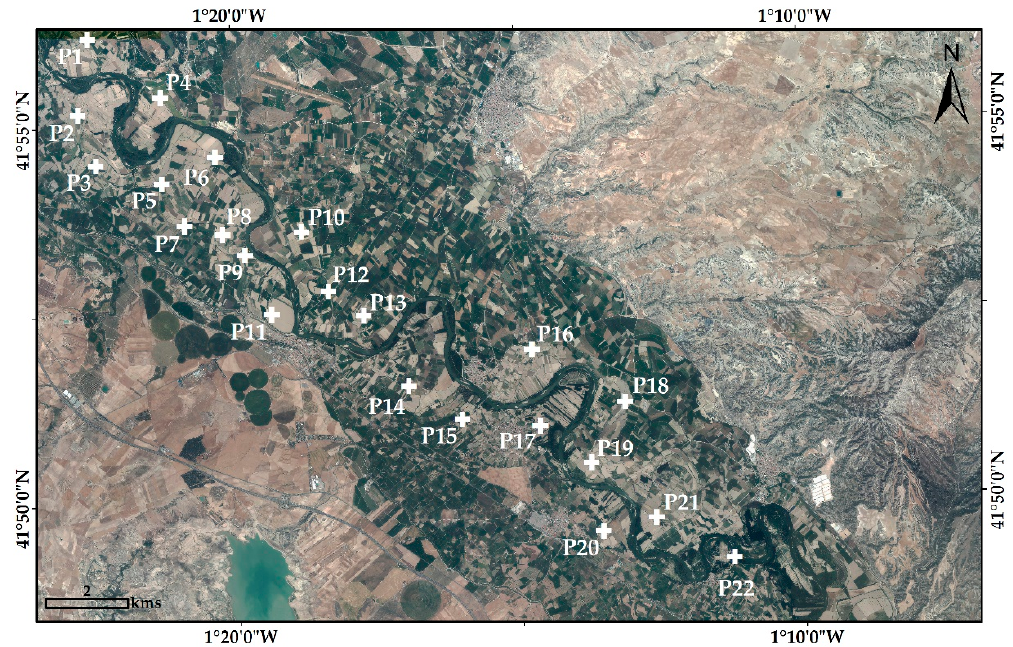
Figure 8. Location map of the points considered in the comparison of backscatter intensity before and after the flooding event.